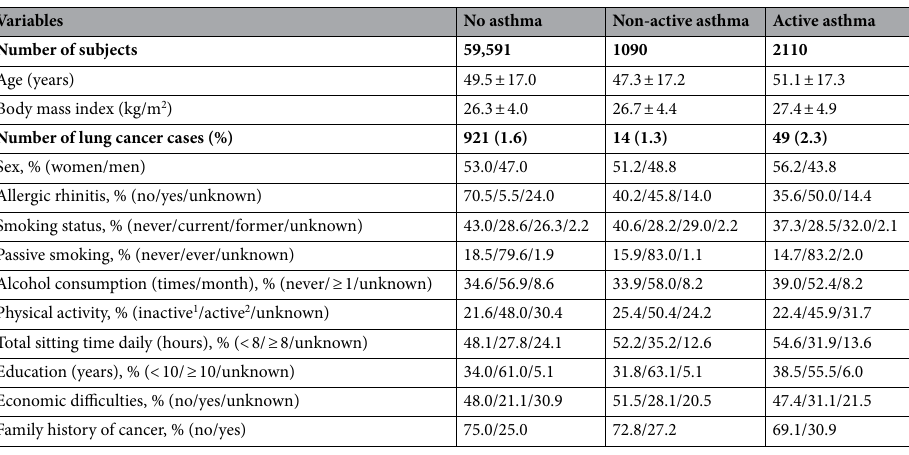
Table 1. Distribution of baseline characteristics according to asthma categories in the HUNT2 Study, 1995–1997 (n = 62,791). HUNT: Nord-Trøndelag Health Study. Data are given as mean ± standard deviation or percentage of subjects in each asthma category. 1 Inactive: no physical activity or only light physical activity ≤ 2 h per week. 2 Active: physical activity level from low to